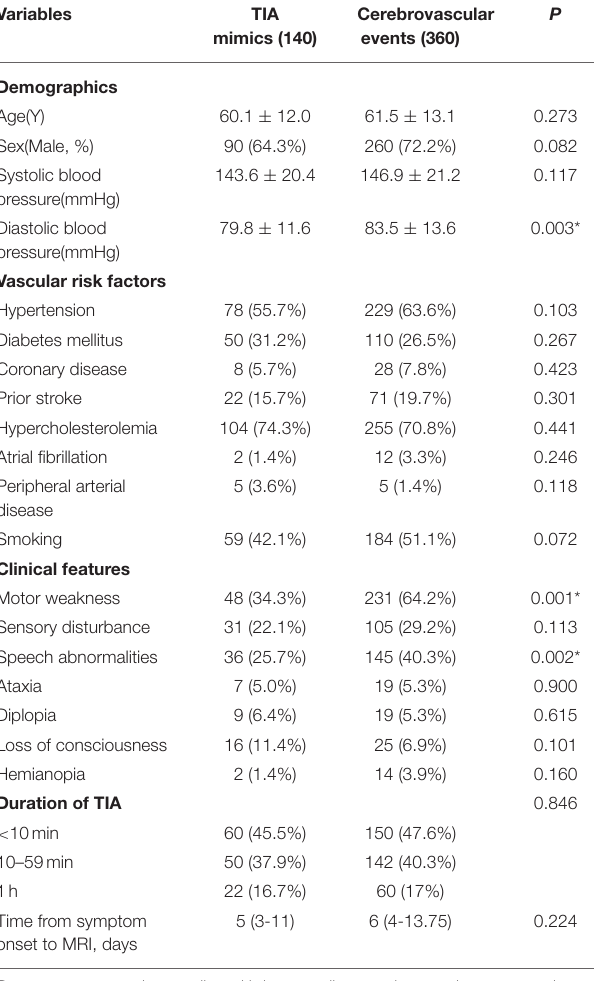
TABLE 4 | The laboratory findings and the risk scores of TIA in all TIA patients. Variables TIA mimics (140)